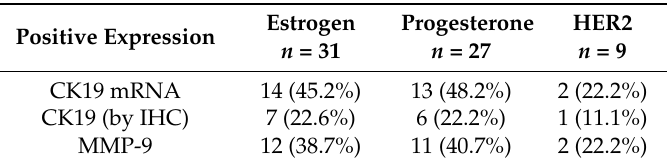
Table 4. Correlation between positive expression of estrogen, progesterone, and HER2, and three markers: CK19 mRNA, CK19 (by IHC), and MMP-9. In all groups p > 0.05. Estrogen Progesterone Positive Expression n = 31 n = 27